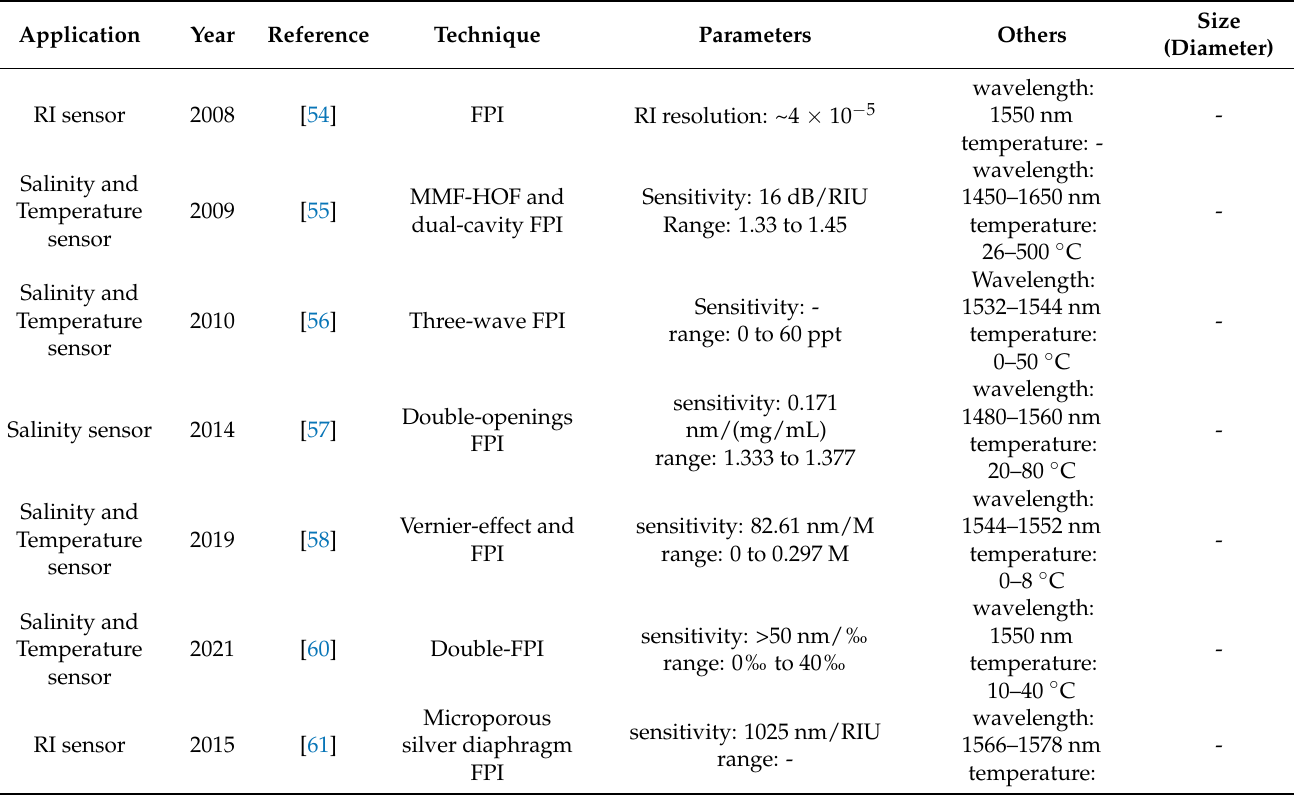
Figure 6. ( a ) Structure of the sensor probe [54]. ( b ) Microscope image of the fabricated FP sensor [55]. ( c ) Schematic of the proposed sensing structure [60]. ( d ) Diagram of the proposed SHNS sensing structure [63]. Table 3. Summary of